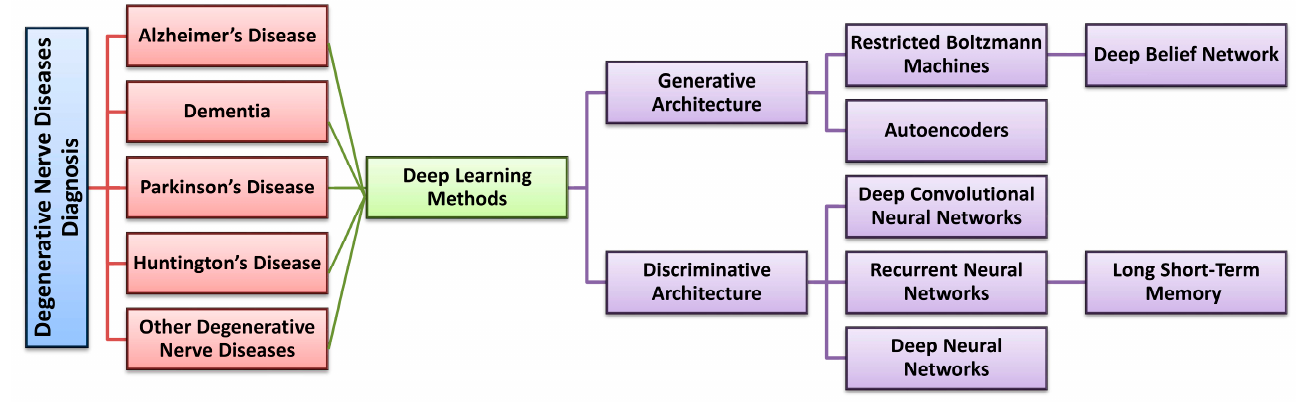
Figure 5. Deep learning models used for degenerative nerve disease diagnosis in this review as a tree illustration.